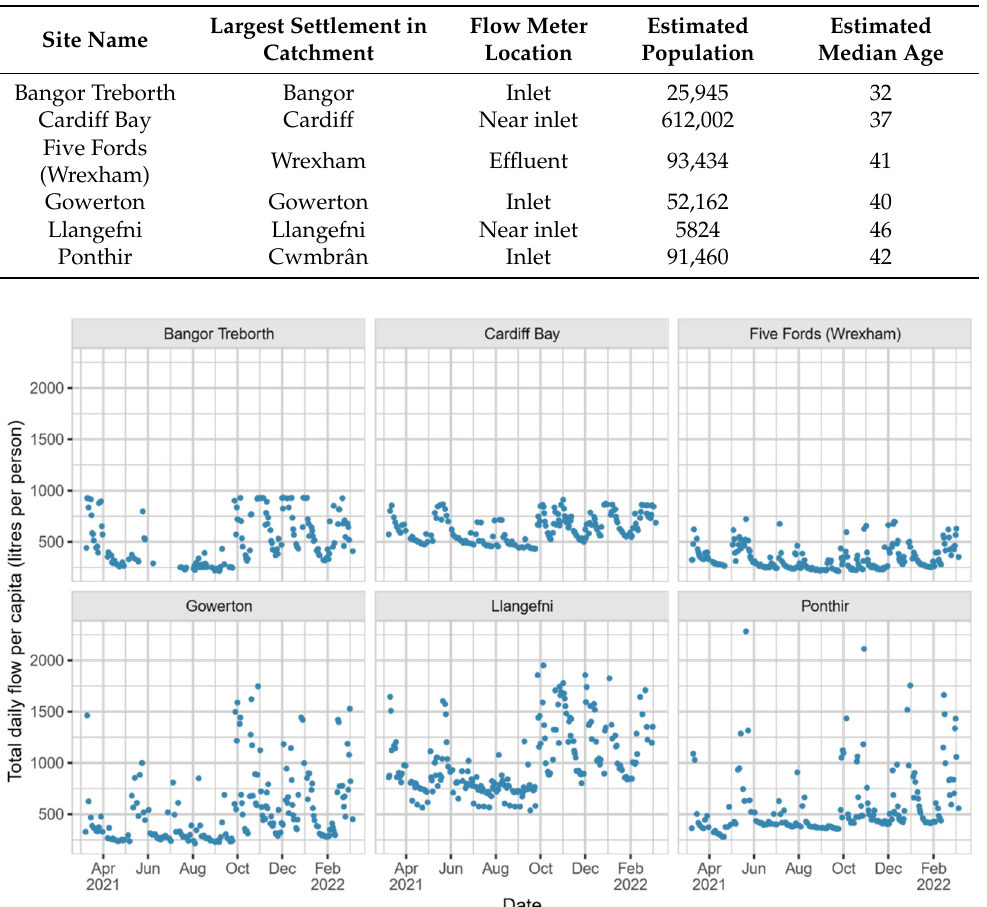
Figure 1. Time series of observed total daily flow at each representative site between March 2021 and March 2022. Table 1. Characteristics of the representative sites under surveillance, with data from the Office for National Statistics (ONS), which provides estimates for the mid-2020 population and age of every Lower Layer Super Output Area (LSOA) in England and Wales.